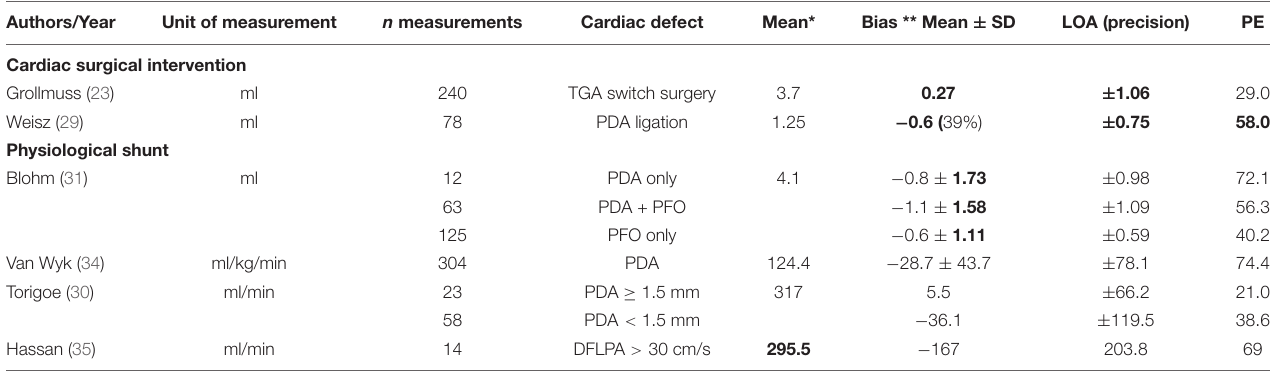
TABLE 7 | Accuracy and precision in studies with cardiac shunts. Authors/Year